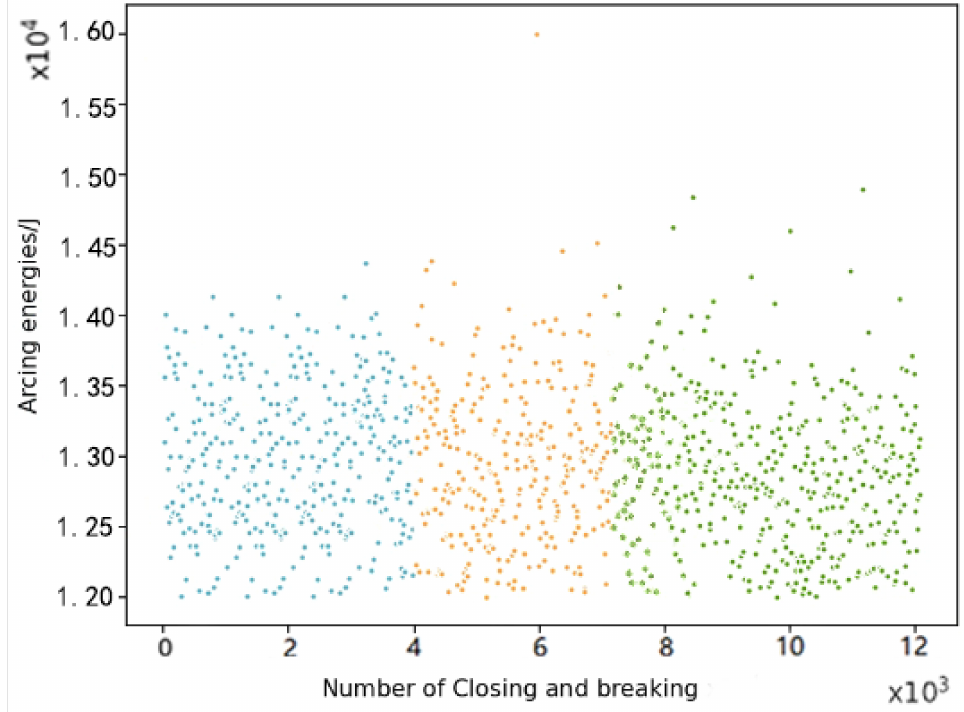
Figure 7. K-means clustering classification graph.